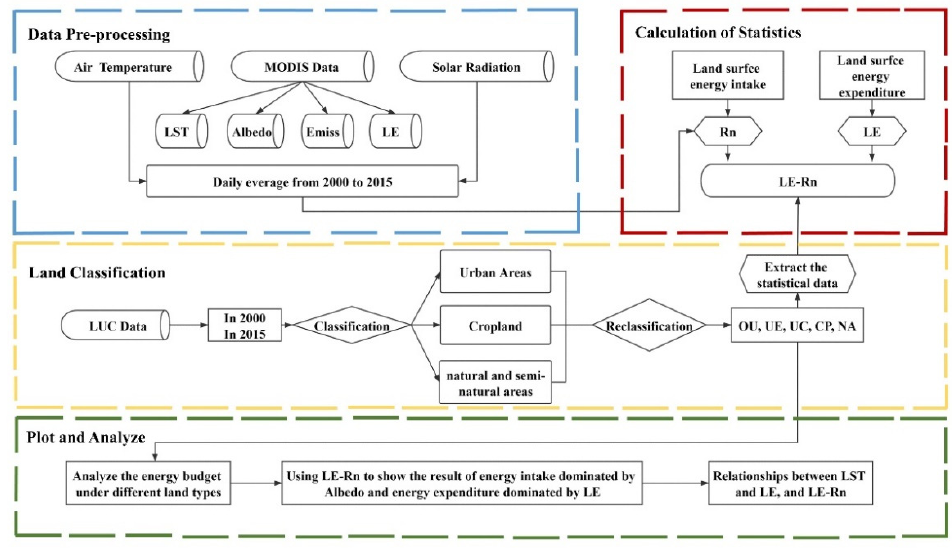
Figure 4. Research framework of energy budget feedback of land use change.